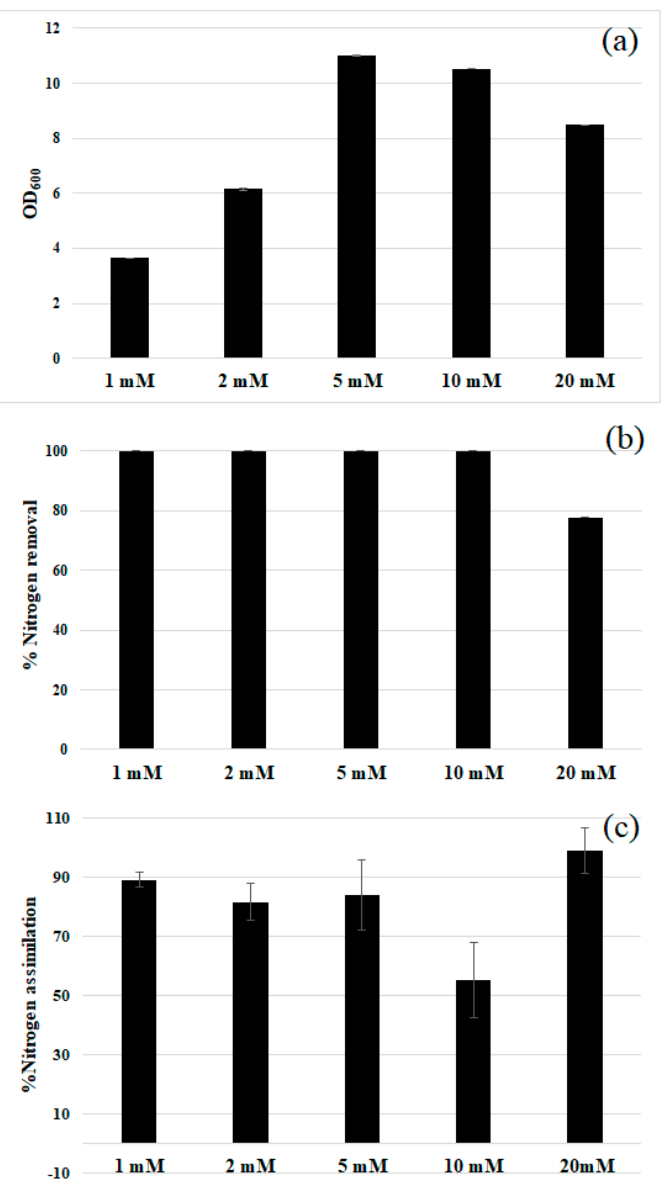
Figure 4. R. diobovata DSBCA06 tolerates up to 20 mM nitrite, with small difference in 48 h growth ( a ); Nitrite removal for each of the tested concentrations in 48 h was almost complete ( b ); showing that it was almost completely assimilated in organic compounds ( c ).